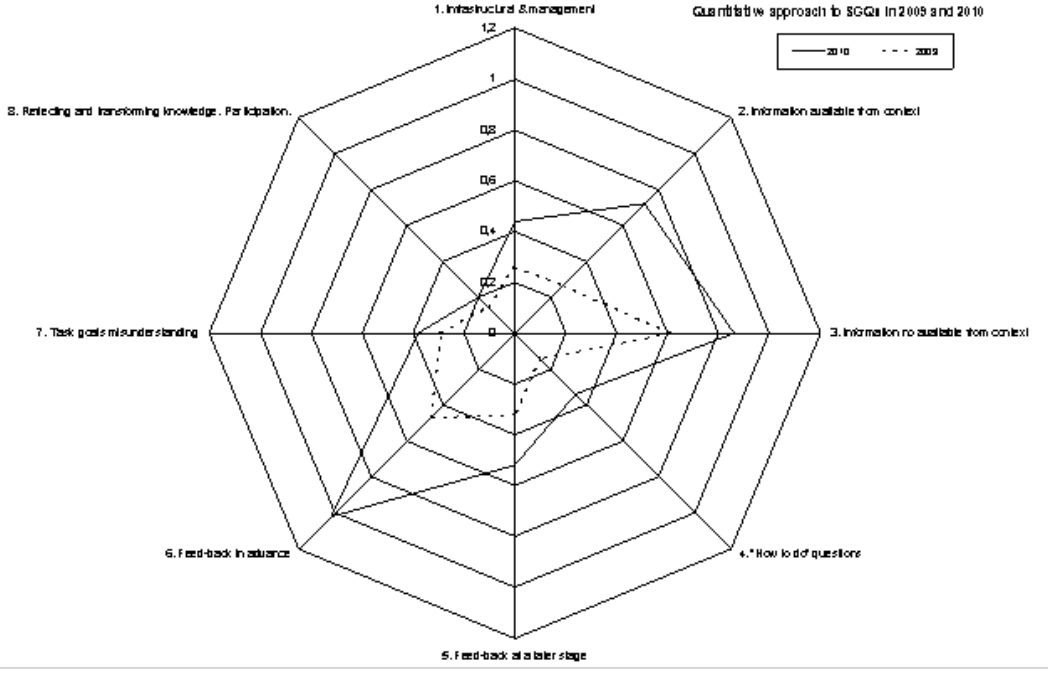
Fig. 2. SGQs occurrence (ratios respect the total amount of questions) in year 2009 and 2010 experiences